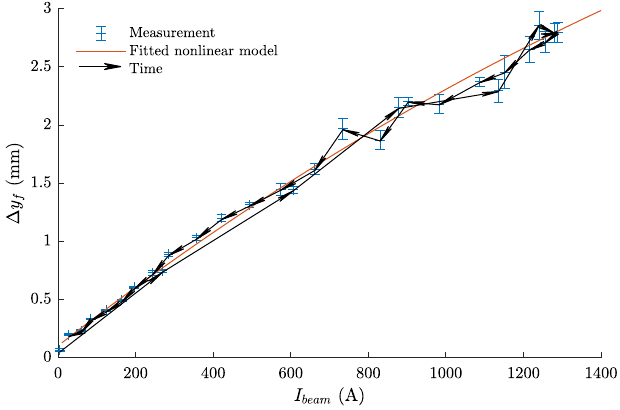
FIG. 4. Beam deflection as a function of current, and a nonlinear fit with used to estimate g and y 0 0 , assuming enh y 0 ¼ − 150 μ m,. The “ time ” arrows points toward measurements where the beam arrives later relative to the start of the discharge, i.e., from left to right in Figs. 2 and